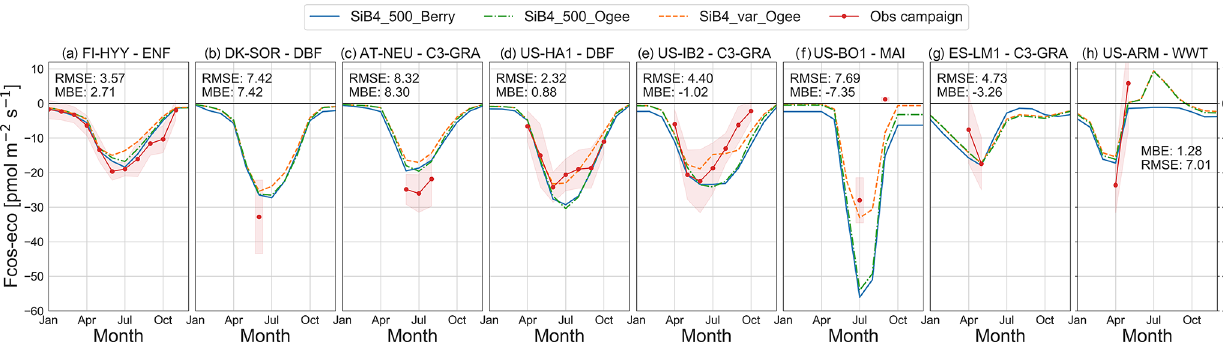
Figure 1. Comparison of ecosystem COS flux seasonal cycles of observations (red) with different SiB4 model runs: the original SiB4 with 500pmolmol − 1 COS and the original Berry soil model (SiB4_500_Berry, solid blue), a run with variable COS mole fractions and the Ogée soil model (SiB4_var_Ogee, dashed orange), and a run with 500pmolmol − 1 COS and the Ogée soil model (SiB4_500_Ogee, dash-dotted green). Monthly averages are shown with the 1 σ spread around the mean of observations. Negative values indicate uptake of COS by the ecosystem, while positive values indicate COS emissions. The model simulations are from the same year(s) in which observations were made. The MBE and RMSE (pmolm − 2 s − 1 ) are given for monthly average fluxes of the SiB4_var_Ogee run. Sites are presented from high to low